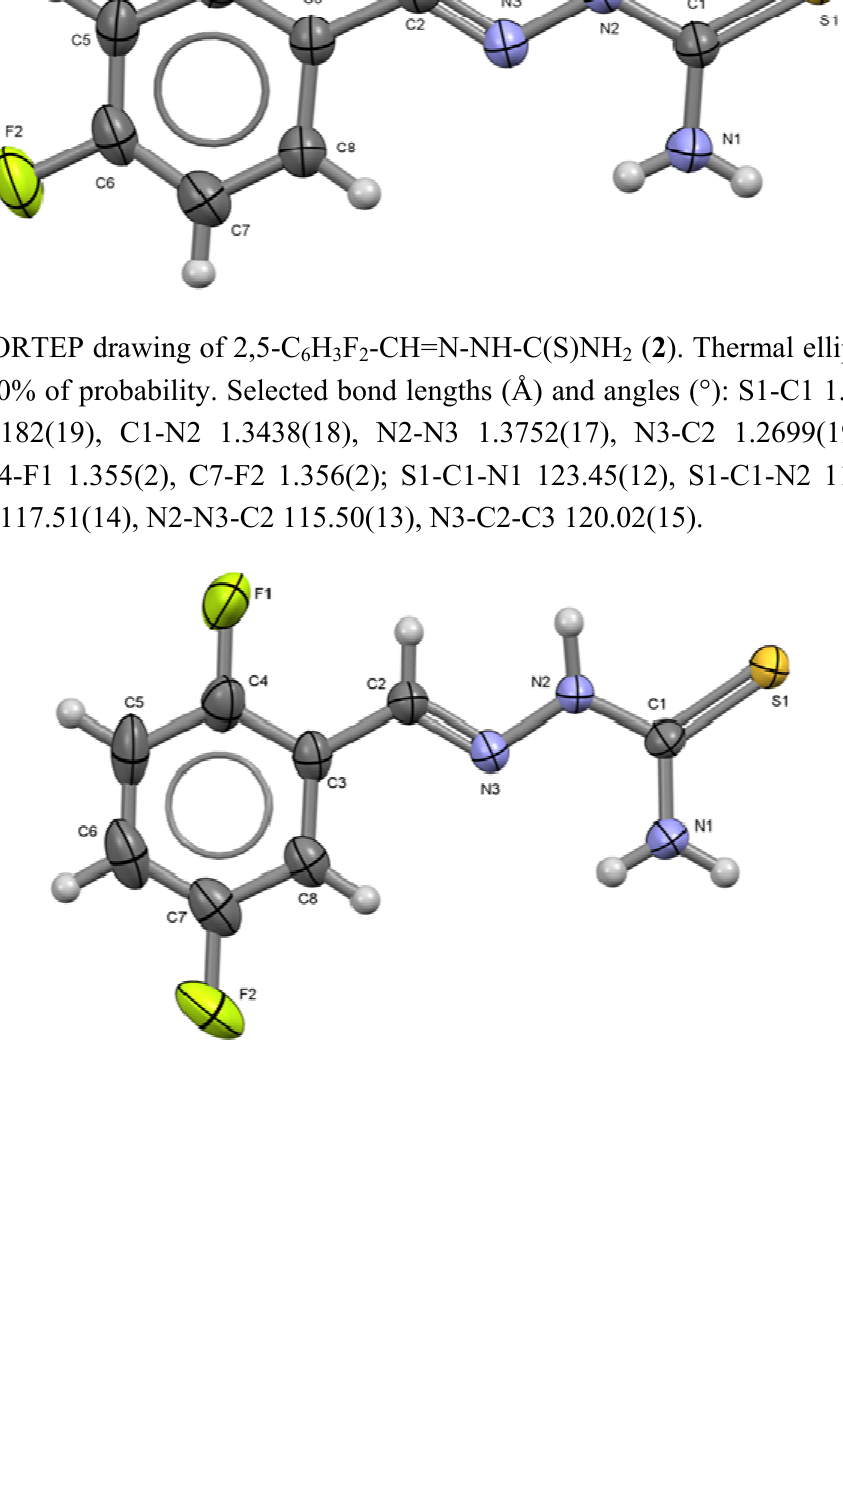
Figure 1. ORTEP drawing of 2,4-C shown at 50% of probability. Selected bond lengths (Å) and angles (°): S1-C1 1.690(16), C1-N1 1.315(2), C1-N2 1.3400(19), N2-N3 1.3692(17), N3-C2 1.2728(19) C2-C3 1.462(2) C4-F1 1.3565(18), C6-F2 1.361(2); S1-C1-N1 122.99(13), S1-C1-N2 119.97(11),